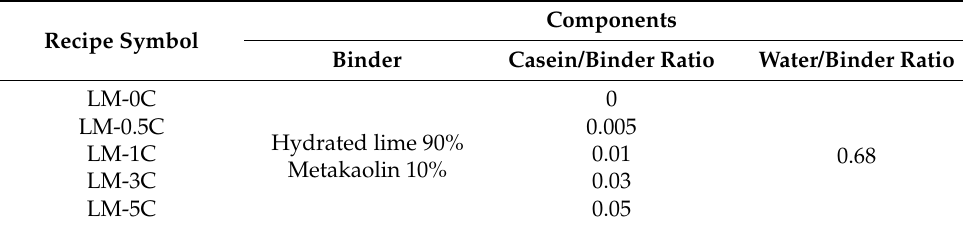
Table 1. Components of the tested